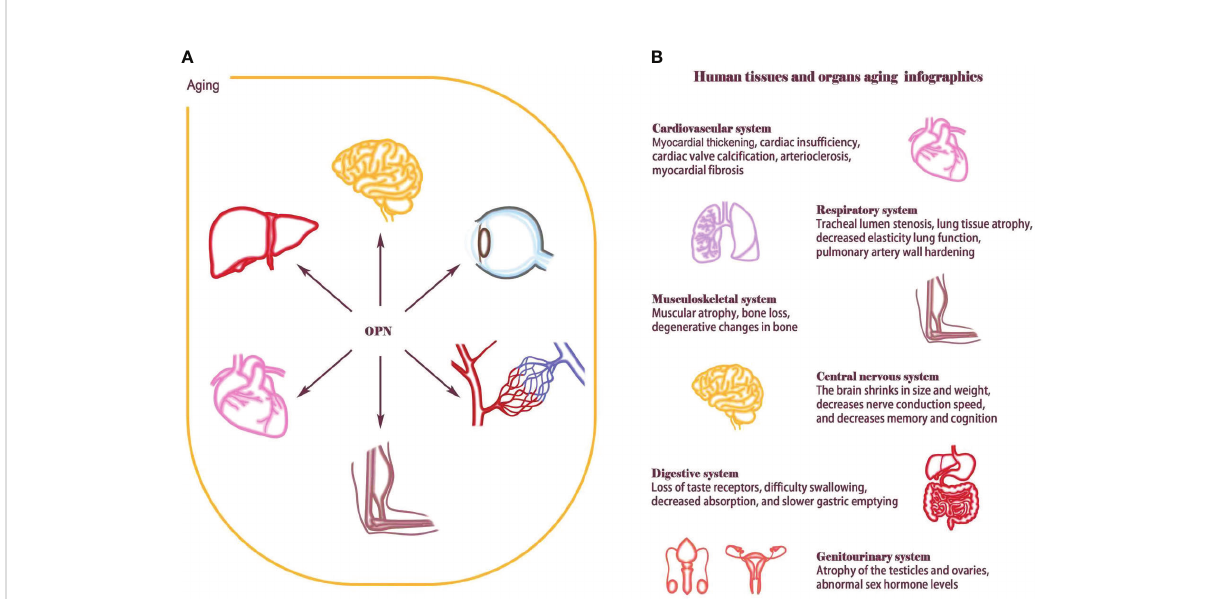
FIGURE 1 Aging affects human tissues and organs. (A) OPN is widely involved in the aging process of multiple organ tissues, such as T-cell senescence, atherosclerosis, skeletal muscle regeneration, osteoporosis, neurodegenerative changes, hematopoietic stem cell reconstruction and retinal aging. (B) Aging is an extremely complex and heterogeneous biological process that involves almost every organ and tissue of the human body. Aging causes cardiovascular diseases such as myocardial thickening, cardiac insuf fi ciency, cardiac valve calci fi cation, arteriosclerosis, and myocardial fi brosis; Lung structure and function change considerably with advancing age, such as tracheal lumen stenosis, lung tissue atrophy, decreased elasticity lung function, pulmonary artery wall hardening. Musculoskeletal system will appear muscle decreases, bone loss, bone degeneration. The central nervous system shrinks in size and weight, decreases nerve conduction speed, and decreases memory and cognition; The aging of the genitourinary system and digestive system also increases the load on the body. Hormone levels are disrupted by atrophy and fi brosis of the ovaries and testes, Digestive system dysfunction and intestinal fl ora imbalance eventually lead to nutrient absorption